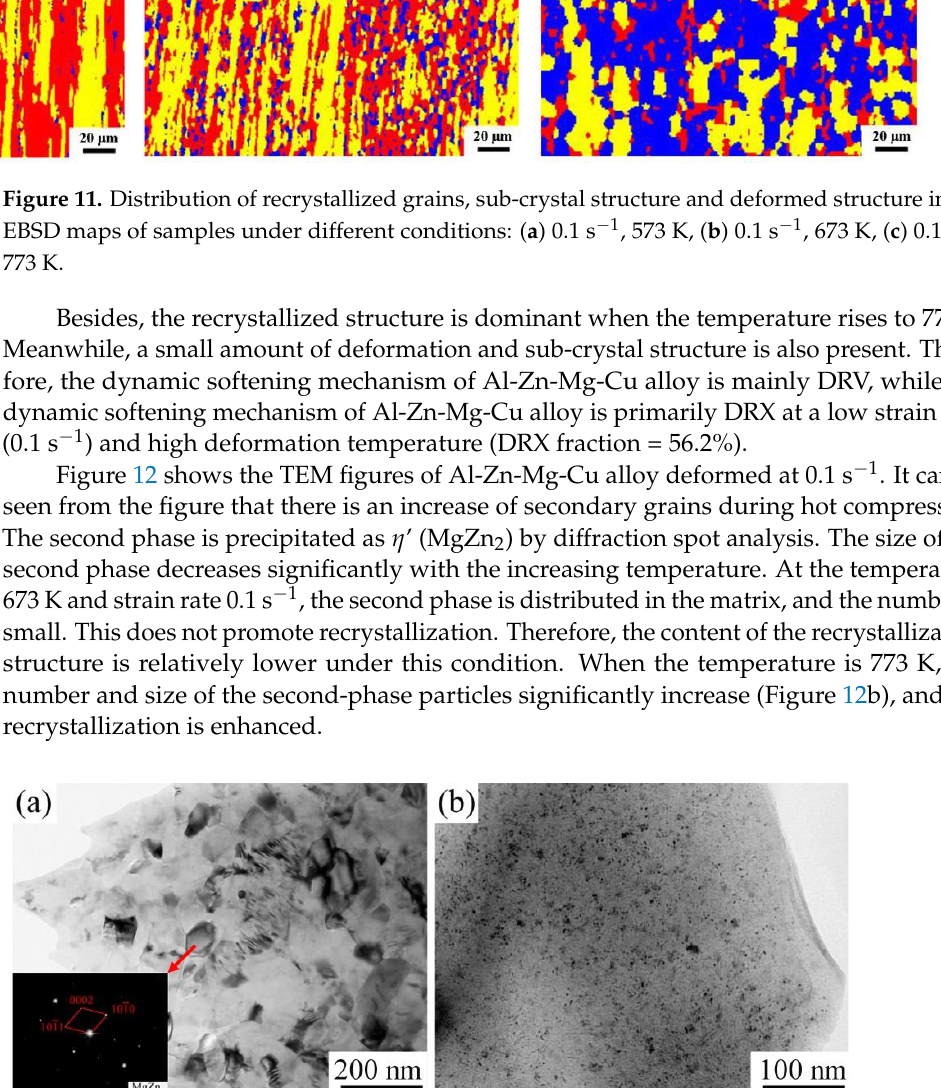
Figure 13. IPF maps, KAM maps and statistics of misorientation angle at different strain rates (T = 673 K) ( a – c ) 𝜀̇ = 0.1 𝑠 −1 ; ( d – f ) 𝜀̇ = 1 𝑠 −1 ; ( g – i ) 𝜀̇ = 10 𝑠 −1 .